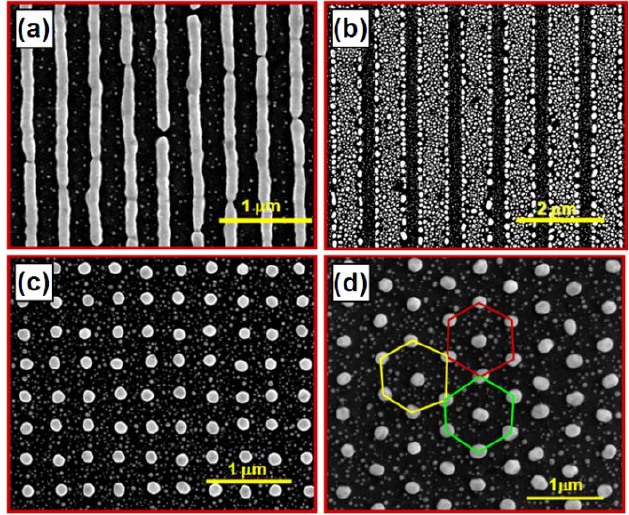
Figure 3. SEM images for different kinds of WMPC structures consisting of: ( a ) gold nanowires; ( b ) hybrid gold nanostructures; ( c ) square lattices of gold nanocylinders; ( d ) triangular lattices of gold nanocylinders.